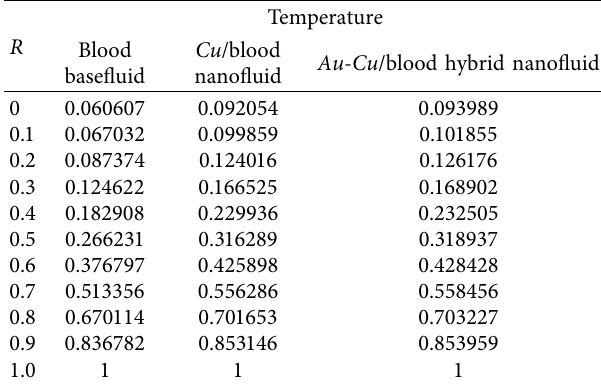
Table 3: Comparison of base fluid, nanofluid, and hybrid nanofluid on